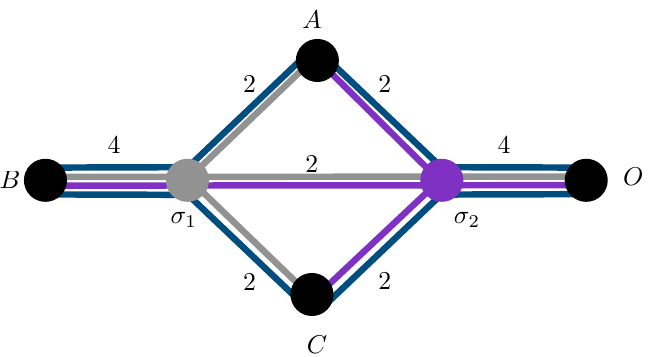
Figure 11 . A maximal configuration of perfect tensor hyperthreads on the 3 boundary graph g for the program (5.7). The configuration consists of two 4-threads one of which splits on each of the two internal vertices as well as four 2-threads shown in blue. The entropy vector in the K -basis is given by K 3 = { 1 , 0 , 1 , 1 , 0 , 1; 2 } which matches the number of perfect tensor hyperthreads of g each species. The objective obtains a value of 4*4+10*2=36. The dual obtains its minimum with a barrier configuration consisting of 2 placed on each edge. This corresponds to a barrier of 1 being placed on each of the RT surfaces corresponding to each of the seven entanglement entropies which make up the entropy vector in the S -basis. Taking into account the capacities, the objective has the optimal value 5*2*2+2*4*2=36. The equality of the two is demanded by the duality and guarantees these configurations are in fact optimal.